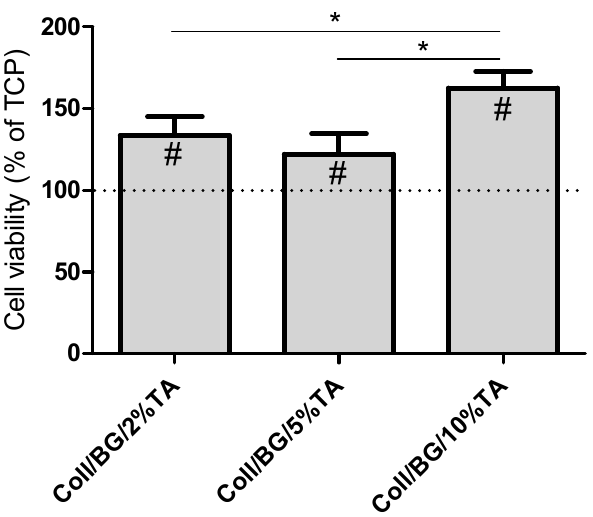
Figure 7. Viability of HaCaT cells after 24-hour exposure to the materials’ extracts prepared by 72-hour soaking of the hydrogels in a culture medium. (* p < 0.05 between groups; #—significant dif- ference with the control).